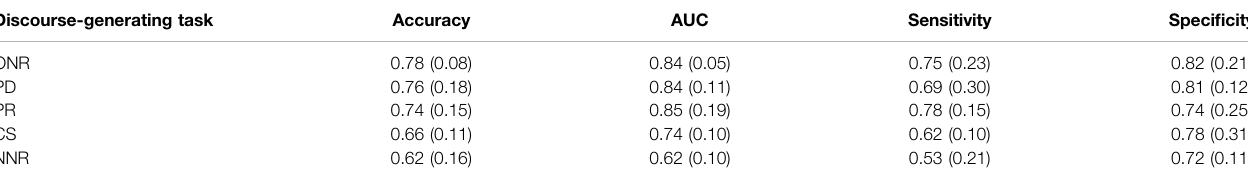
TABLE 3 | HC vs. AD+MCI mean (s.d) SVM classi fi cation performance across fi ve-fold cross validation for fi ve connected speech tasks, ranked by accuracy. Discourse-generating